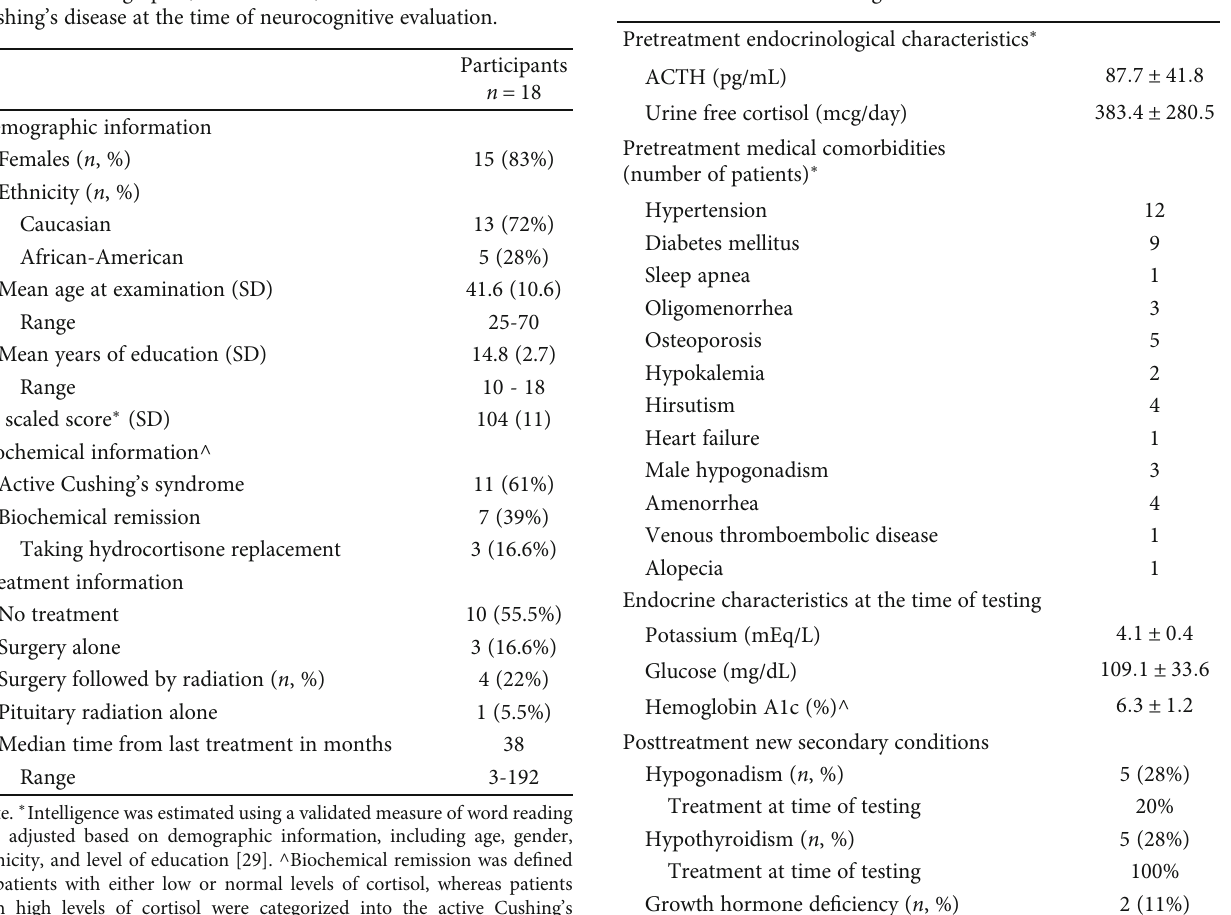
Table 2: Endocrinological and medical